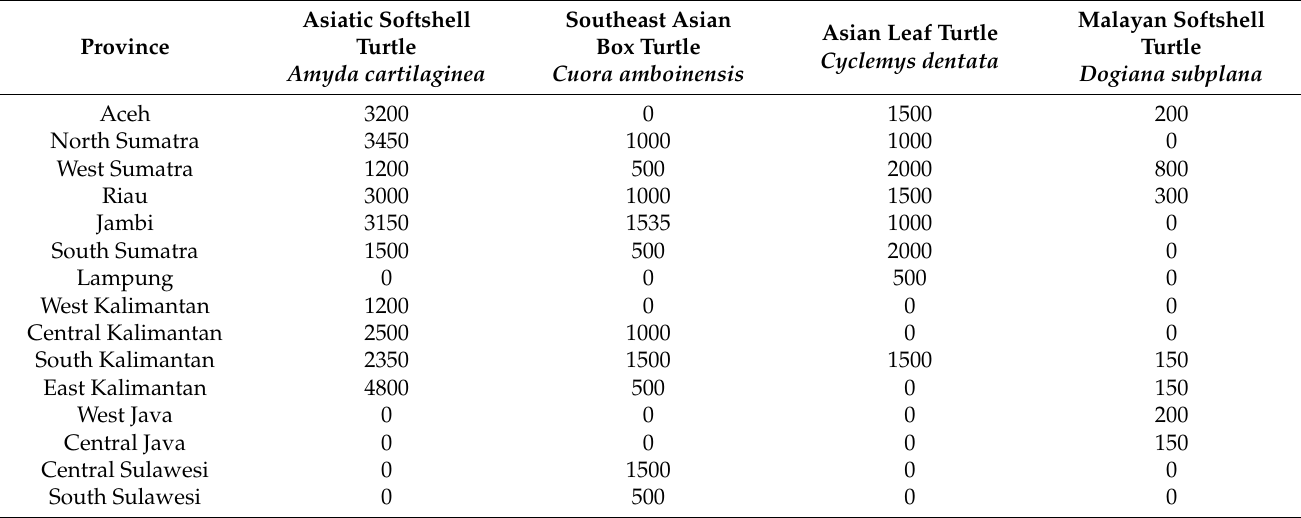
Table 1. Harvest quotas (in number of individuals) for four commercially traded co-occurring freshwater turtles and tortoises for the year 2020. This trade is for meat and additional (smaller) numbers are allowed to be harvested to meet the demand for the pet trade. Asian leaf turtle also included C. enigmatica